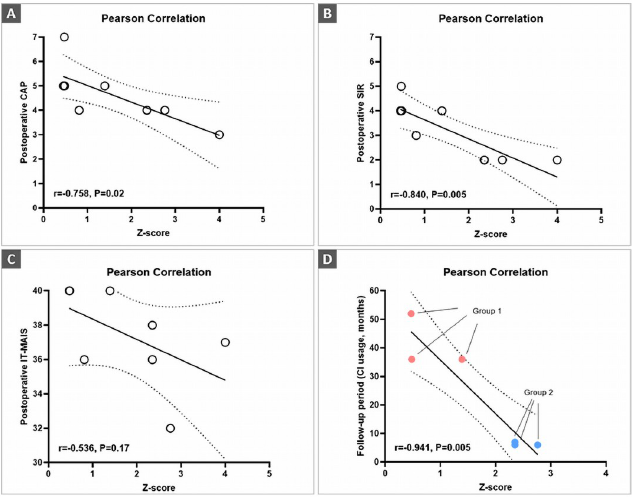
Fig 4. Correlation analyses of the auditory performance and P1 latency. (A, B) The Z-scores were found to be inversely correlated with preoperative CAP (r = -0.758, P = 0.02) and SIR (r = -0.840, P = 0.005). (C) A better Z-score as reflected by shorter P1 latency did not correlate with a higher postoperative IT-MAIS score, although a very weak tendency was observed (r = -0.536, P = 0.17). (D) The Z-scores were found to be inversely correlated with the follow- up duration between CI and CAEP testing, observed only in subjects included in groups 1 and 2 (r = -0.944, P = 0.005). The grey dotted color indicates the 95% confidence